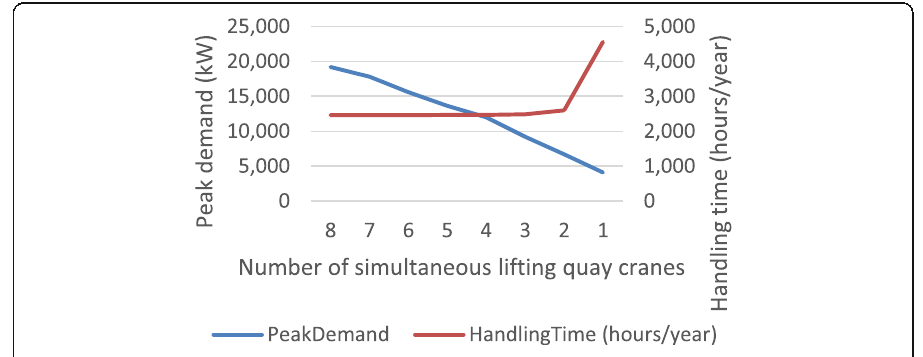
Fig. 6 Relation between peak demand and handling time when the number of lifting cranes is